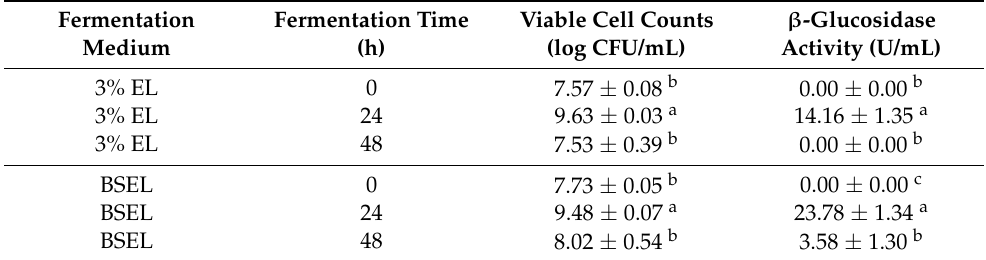
Table 1. Comparison of viable cell counts and β -glucosidase activity of L. plantarum BCRC 10357 for 3% EL in MRS broth (3% EL) and 3% EL in black soymilk (BSEL) during 48 h of fermentation 1